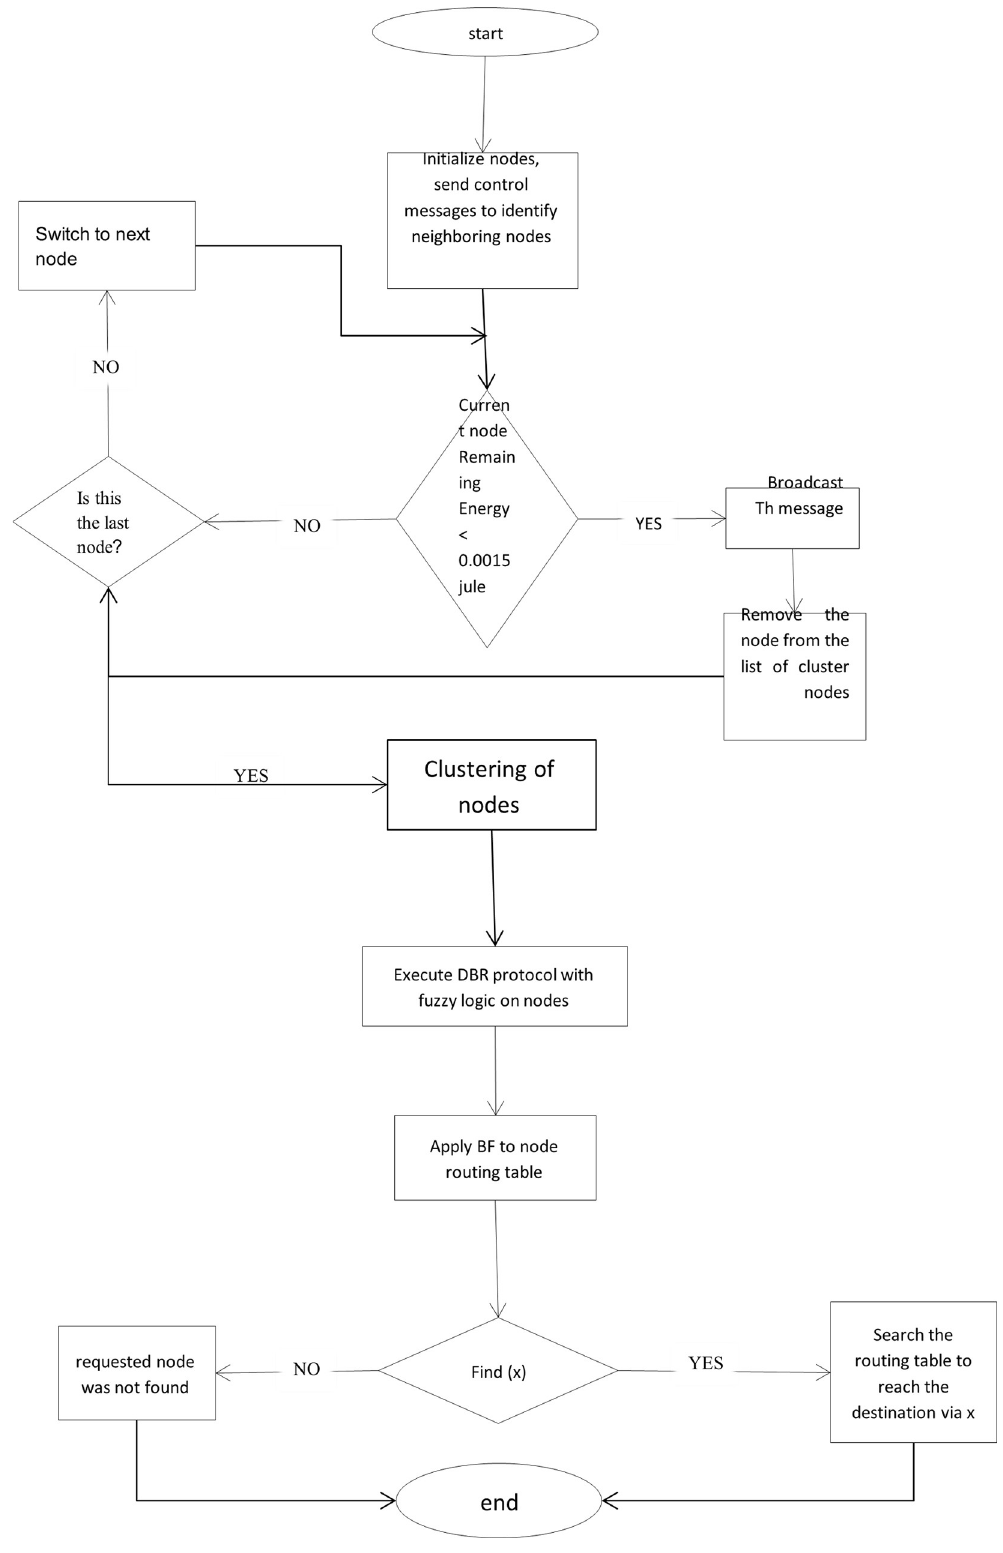
Fig 2. Flowchart of how the proposed method works